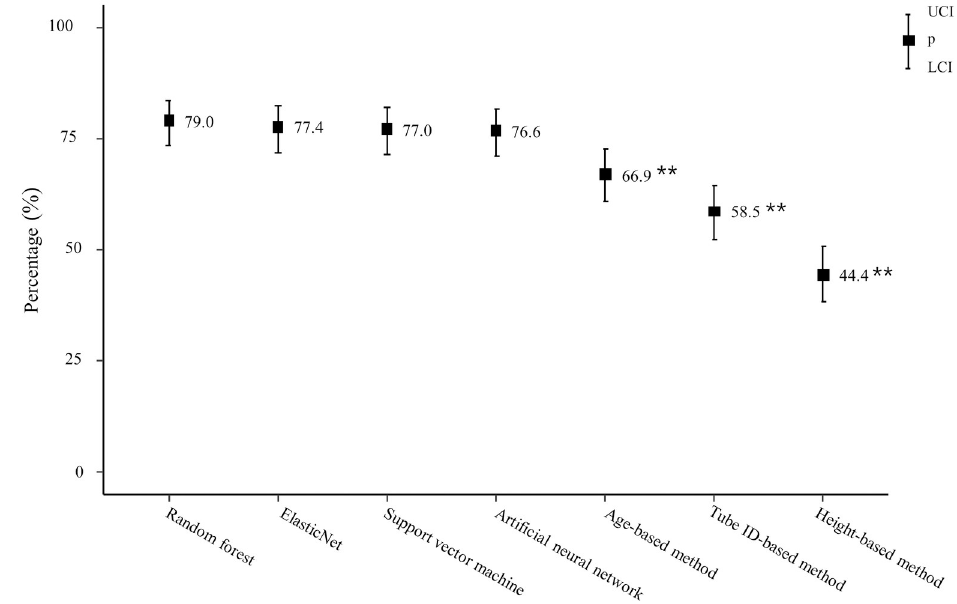
Fig 3. Percentage of tracheal tube tip positioned in optimal location. (Random forest method versus Age-based method or Tube ID-based method or Height-based method). Comparisons between the random forest and formula based methods (Age-based method, Tube ID-based method and Height-based method) were performed using the McNemar test, respectively. �� p < 0.001.